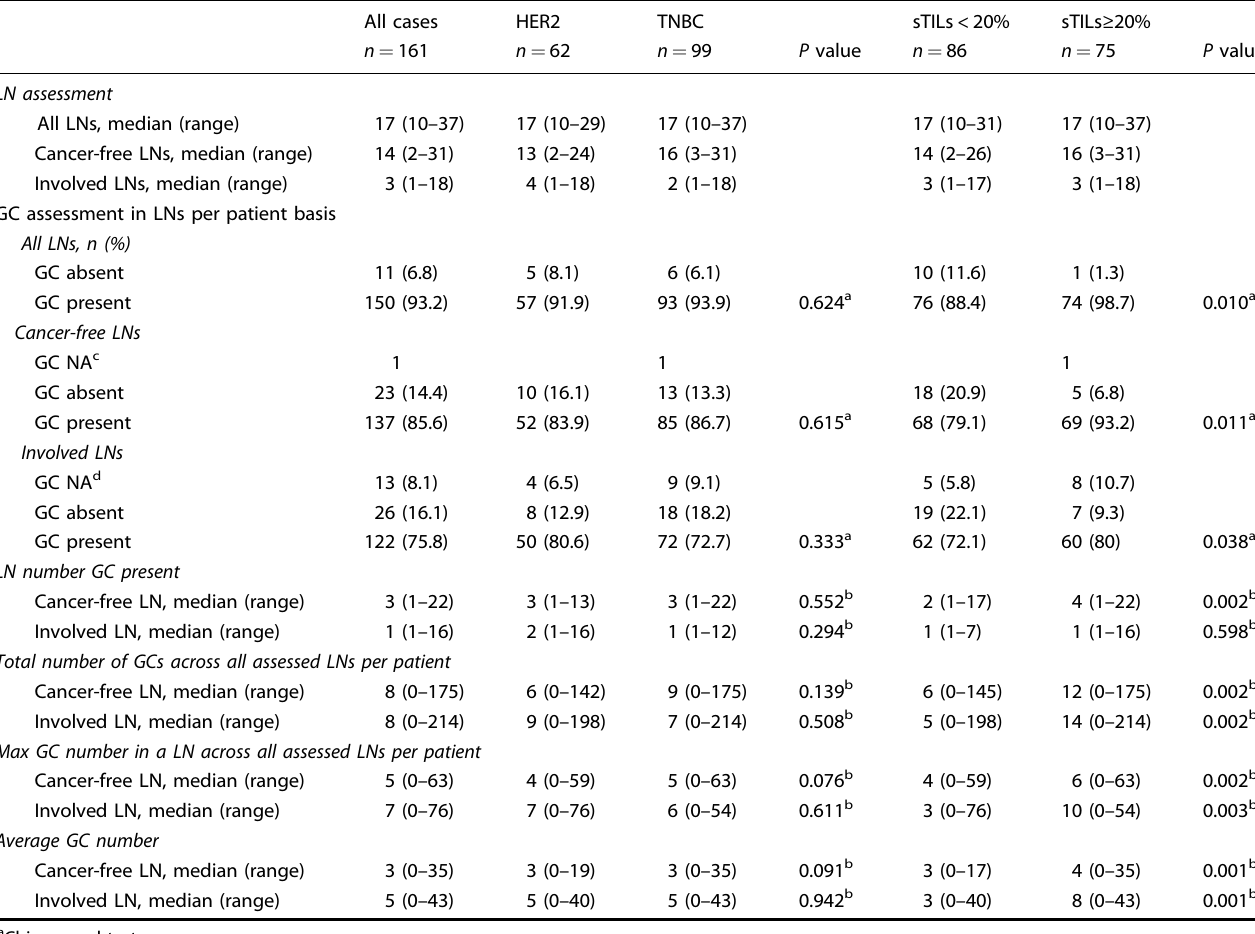
Table 2. Germinal centers in involved and cancer-free lymph